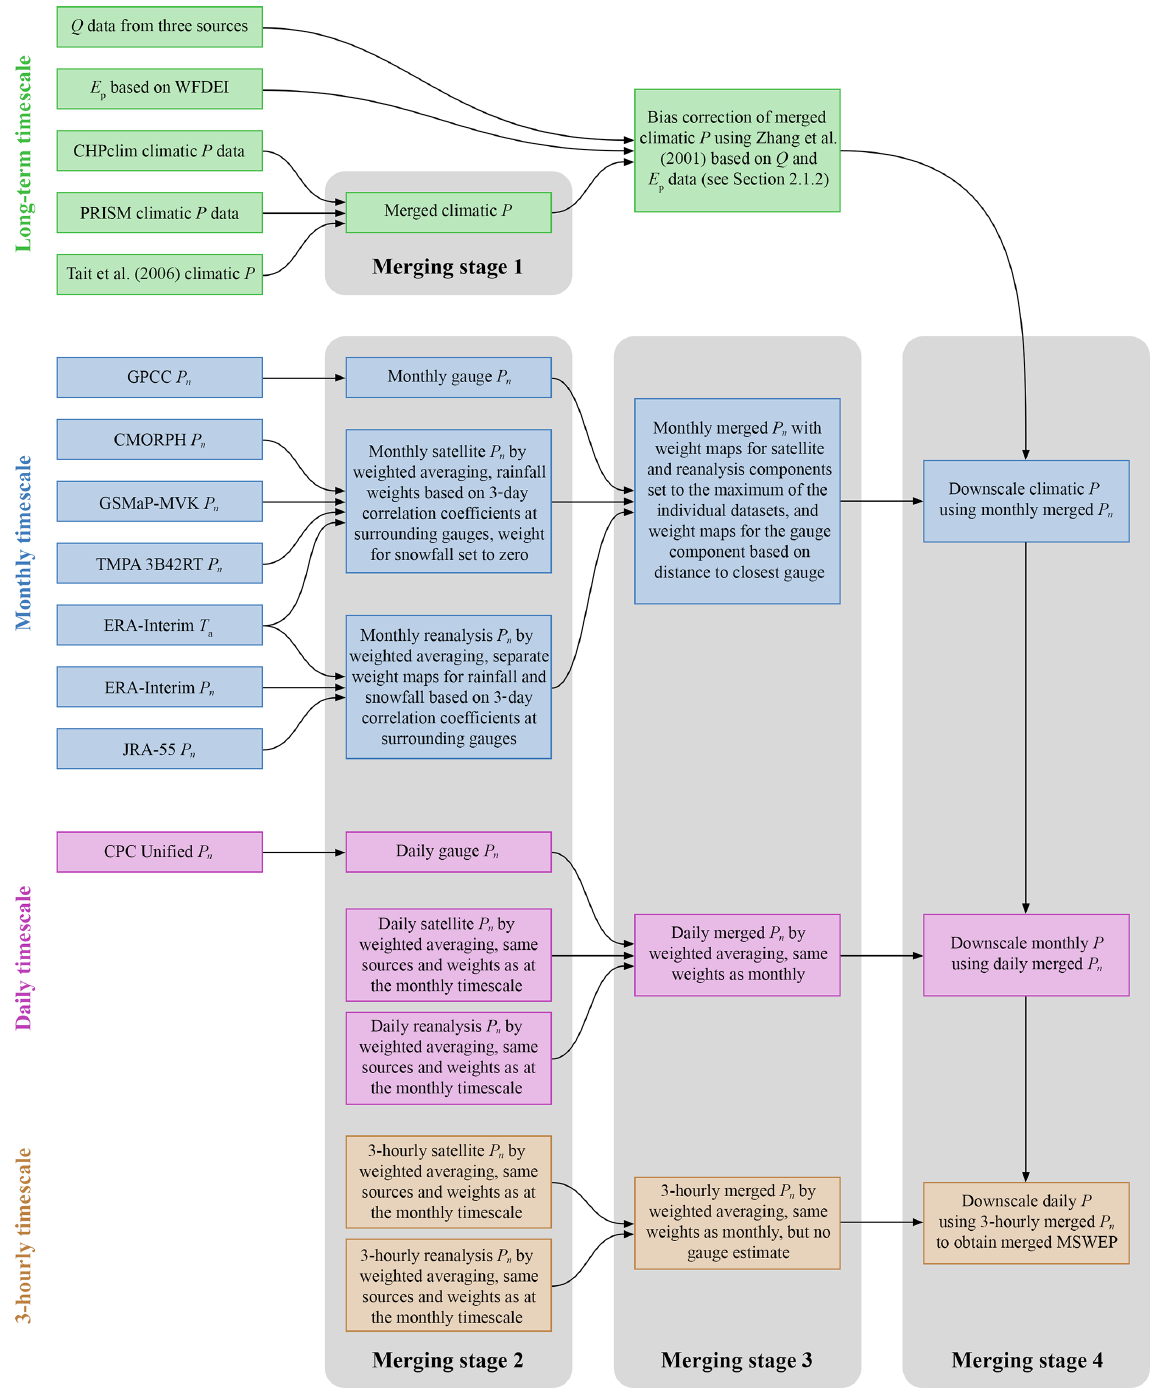
Figure 1. Flow chart summarizing the main steps carried out to produce MSWEP. The different colors represent different timescales. P n refers to normalized P (i.e., P